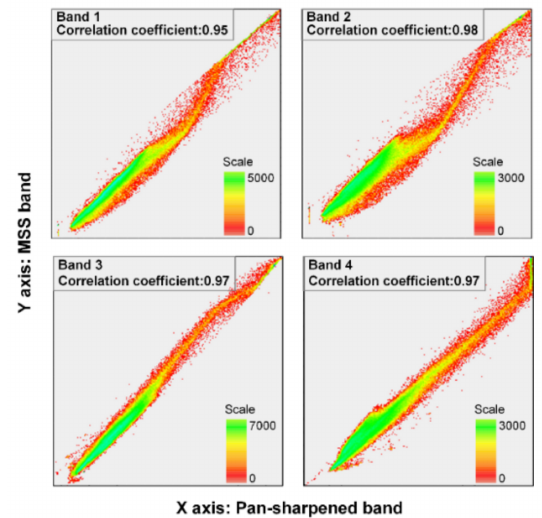
Figure 3. Analysis of the correlation between the original multispectral (MSS) bands and the pan-sharpened bands. The scale refers to the frequency of